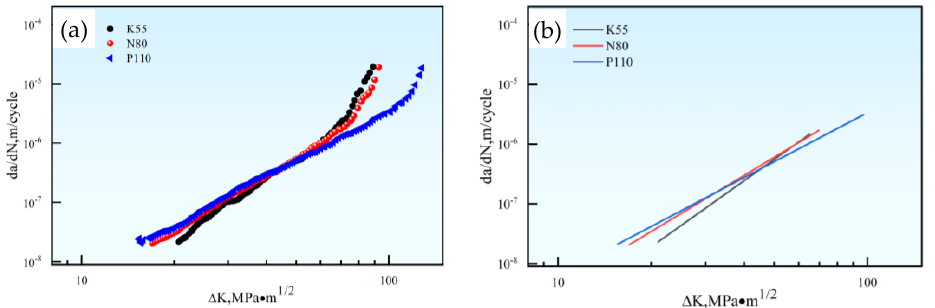
Figure 7. Curves (d a /d N versus ∆ K ) for three types of casing drilling steels: ( a ) Fatigue crack growth curves for three types of casing drilling steels; ( b ) Paris ’ law curves for three types of casing drilling steels.